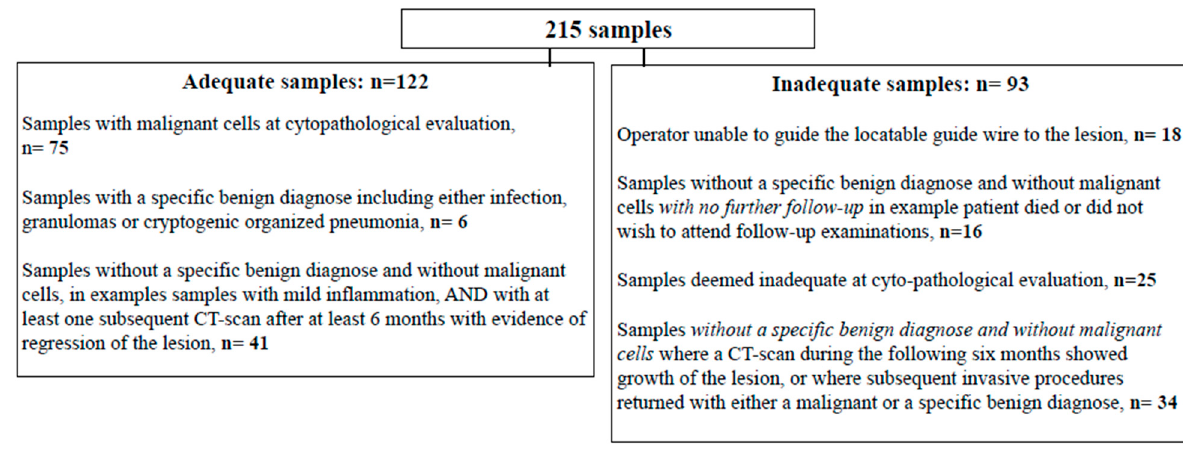
Table 1. Procedure and lesion